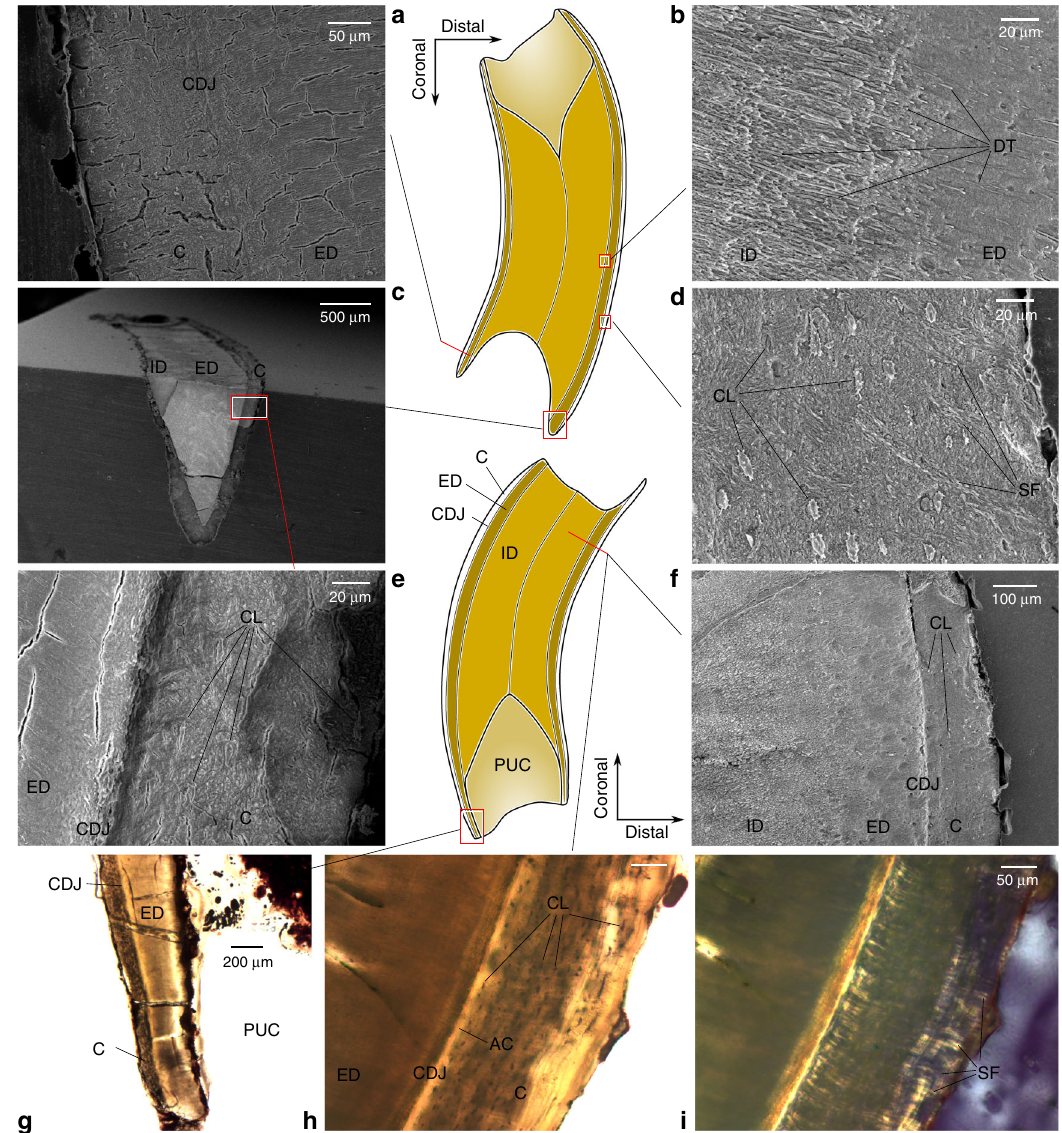
Fig. 2 Menadon besairiei postcanine dental microstructure. a , f , h , i , cross sections; b , d , g , longitudinal sections; c , e , longitudinal (labio-lingual) section. AC acellular cementum, C cementum, CDJ cement – dentine junction, CL cementocytes lacunae (secondarily fi lled), DT dentine tubules, ED external dentine, ID internal dentine, PUC,pulp cavity, SF Sharpey fi